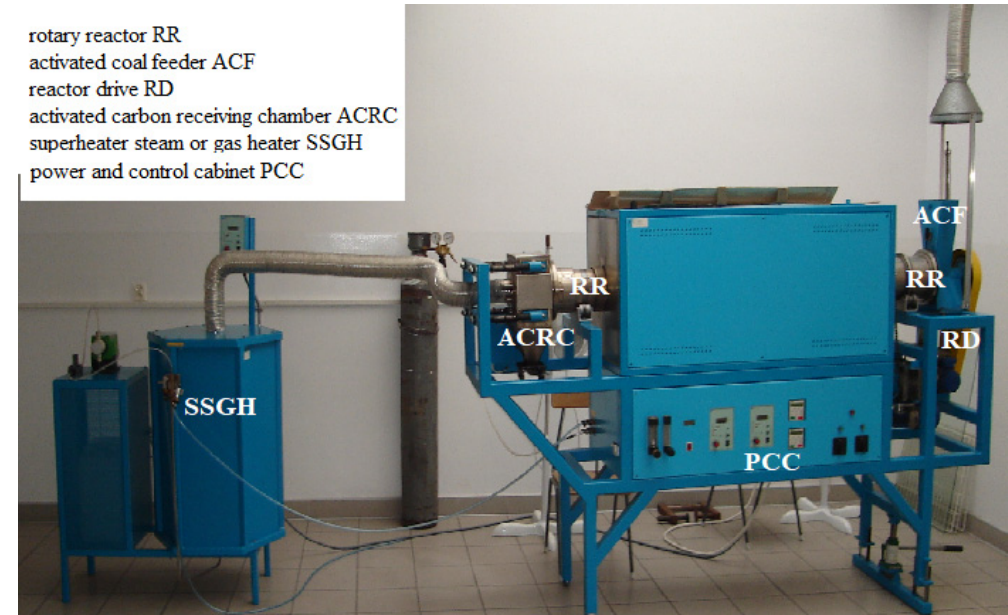
Figure 2. Testing stand for the high-temperature modification of activated carbon.